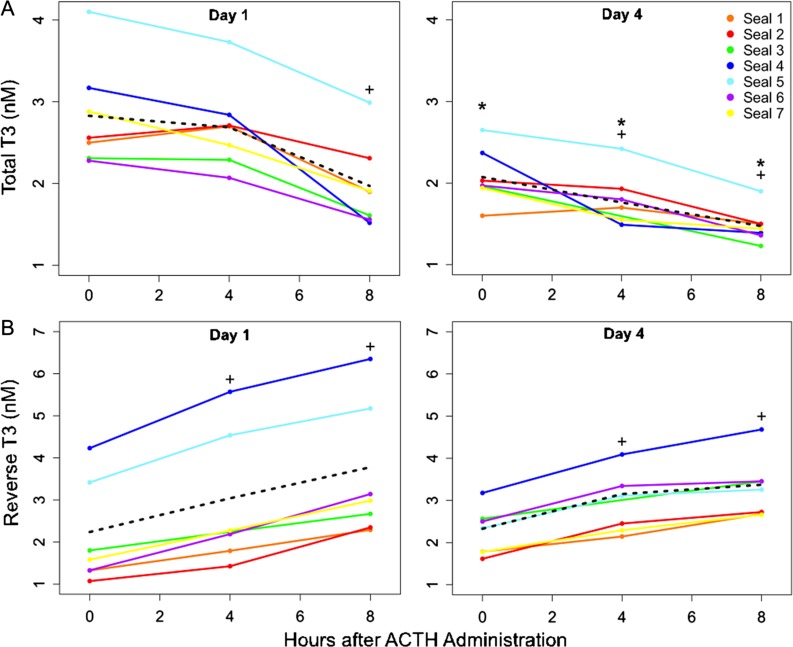
(A) Total T3 concentrations measured 8 h after ACTH administration were significantly decreased relative to pre-ACTH (0-h) levels on Days 1 (left panel) and 4 (right panel). Total T3 concentrations measured post-ACTH were significantly decreased relative to pre-ACTH (0-h) levels on Days 1 (left panel) and 4 (right panel; LMM: F2, 12 = 25.3, 18.4 for Days 1 and 4, respectively, P < 0.0001). Total T3 levels were suppressed on Day 4 relative to Day 1 (paired t-test, P < 0.001). (B) Reverse T3 concentrations measured 4 and 8 h after ACTH administration were significantly increased relative to pre-ACTH (0-h) levels (LMM: F2, 12 = 57.0 and 18.4 for Days 1 (left panel) and 4 (right panel), respectively, P < 0.0001), but did not differ between days. The dashed lines show mean hormone concentrations. + denotes hormone values that were significantly different (P < 0.05) from the 0-h sample on that day. * denotes values that were significantly different (paired t-test, P < 0.001) between Days 1 and 4.